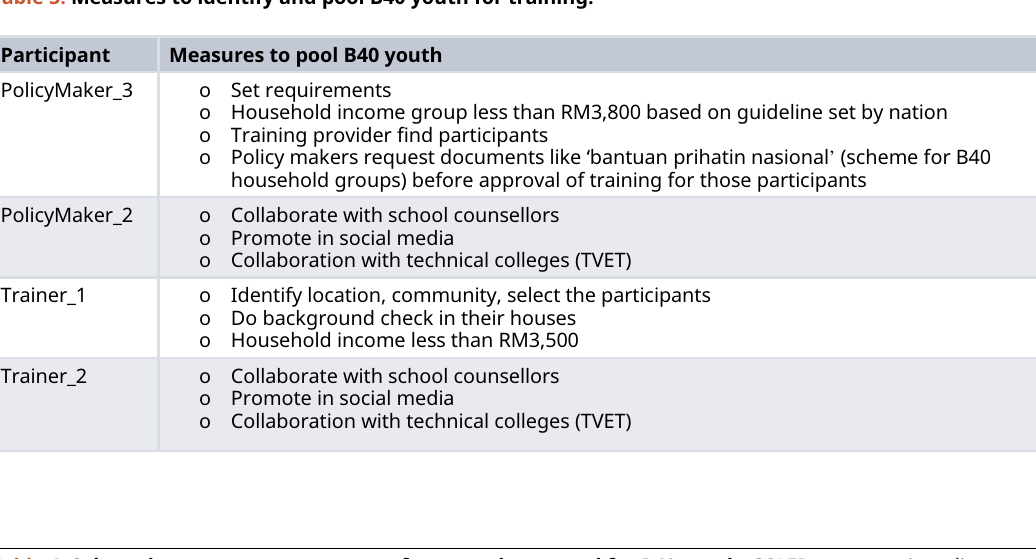
Table 6. Selected excerpts on governance framework targeted for B40 youth. COVID = coronavirus disease